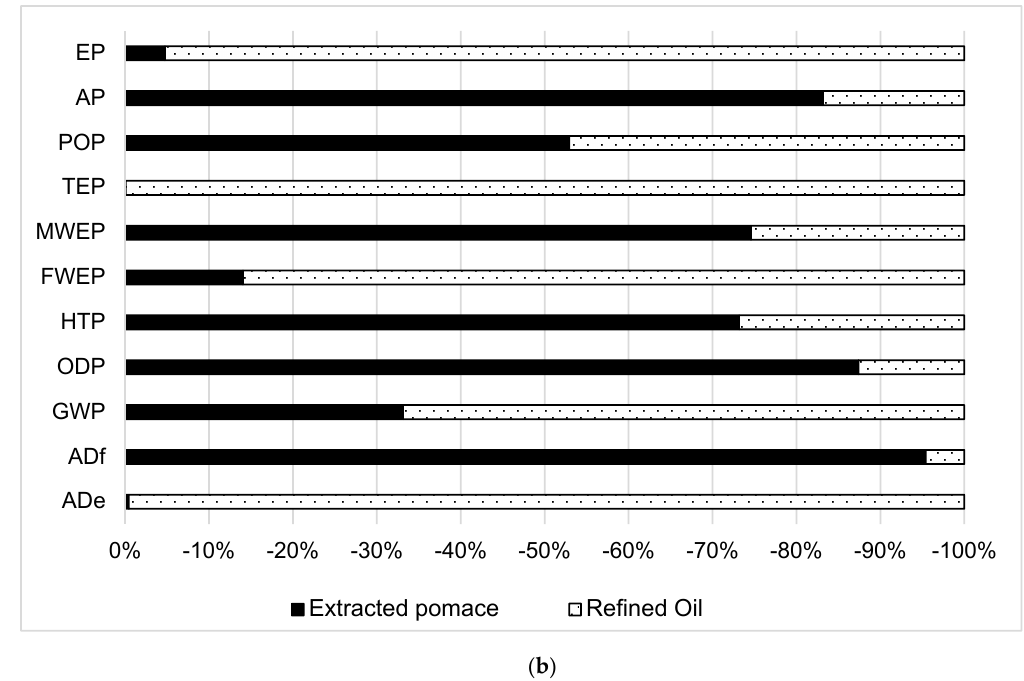
Figure 4. Percentage contribution to the impacts for crude olive pomace oil extraction, burning natural gas (OPOE-A): ( a ) positive contribution; ( b ) credits.